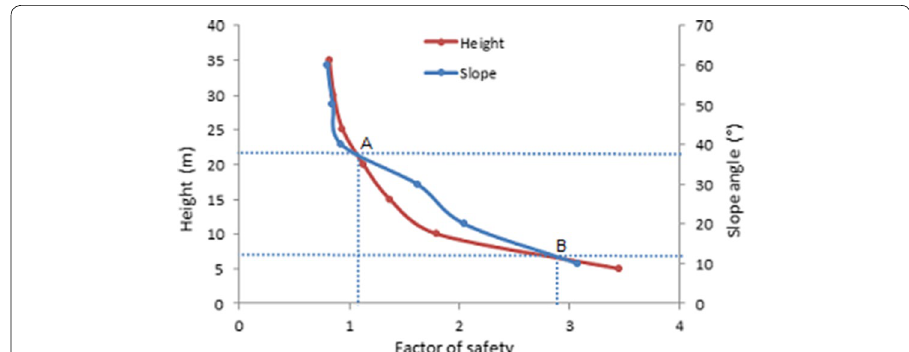
Fig. 13 Effects of dump slope height and angle on the slope stability